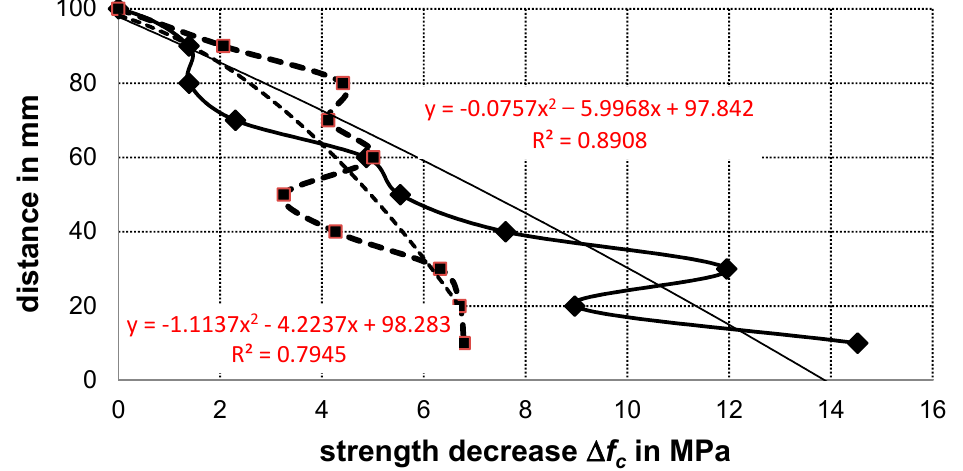
Figure 13. Distribution of compressive strength decrease in the samples no. 008 (continuous line) and 011/2 (dashed line). ( Δ f c = f c ( depth = 100 mm ) − f c ( current depth ) ).